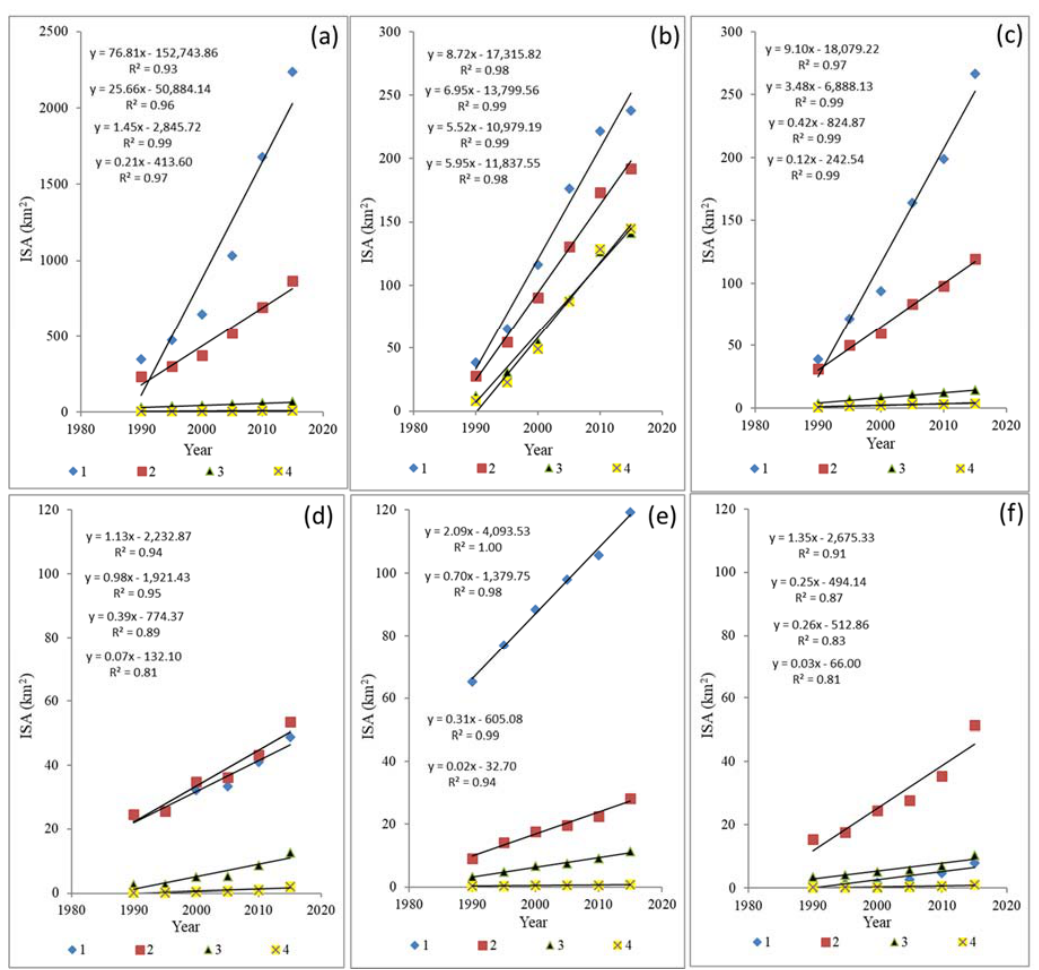
Figure 8. The change in ISA over time based on four elevation ranges; ( a ) Shanghai, ( b ) Shenzhen, ( c ) Ho Chi Minh City, ( d ) Ulaanbaatar, ( e ) Lanzhou, and ( f ) Vientiane; 1, 2, 3, 4 represent four elevation ranges based on elevations of the metropoles (<10, 10–20, 20–30, and >30 m for Shanghai and Ho Chi Minh City; <20, 20–40, 40–60, and >60 m for Shenzhen because of its relatively higher elevations; considerably different elevation ranges among the three inland cities require different ranges in